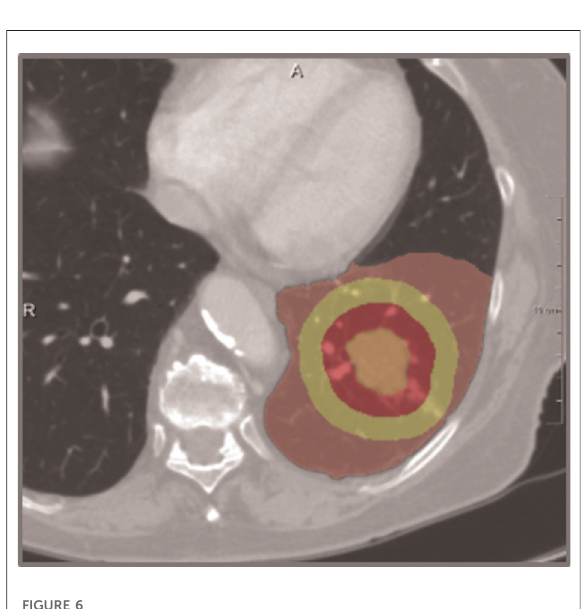
FIGURE 6 Safety margin between tumor and segment